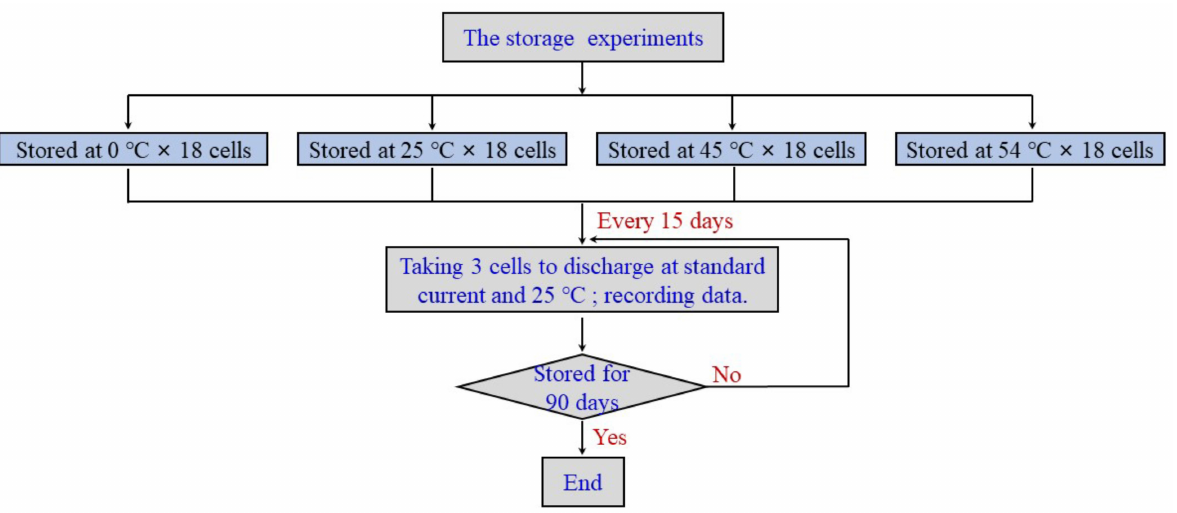
Figure 2. The flow chart of the storage